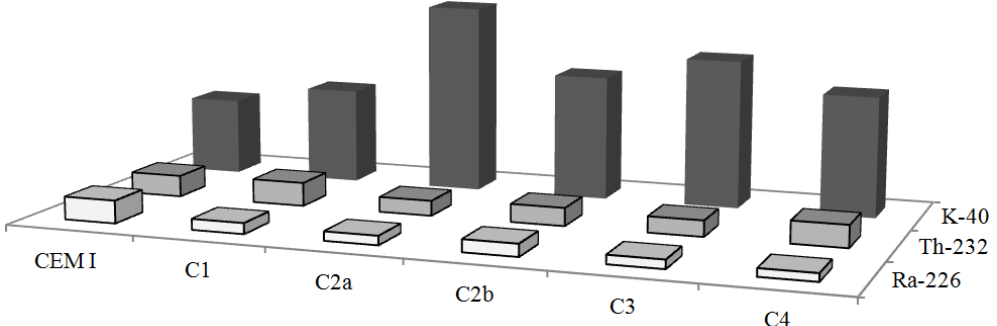
Figure 1. Comparison between the average values of 226 Ra, 232 Th and 40 K activities for cement (used in composites) and cement